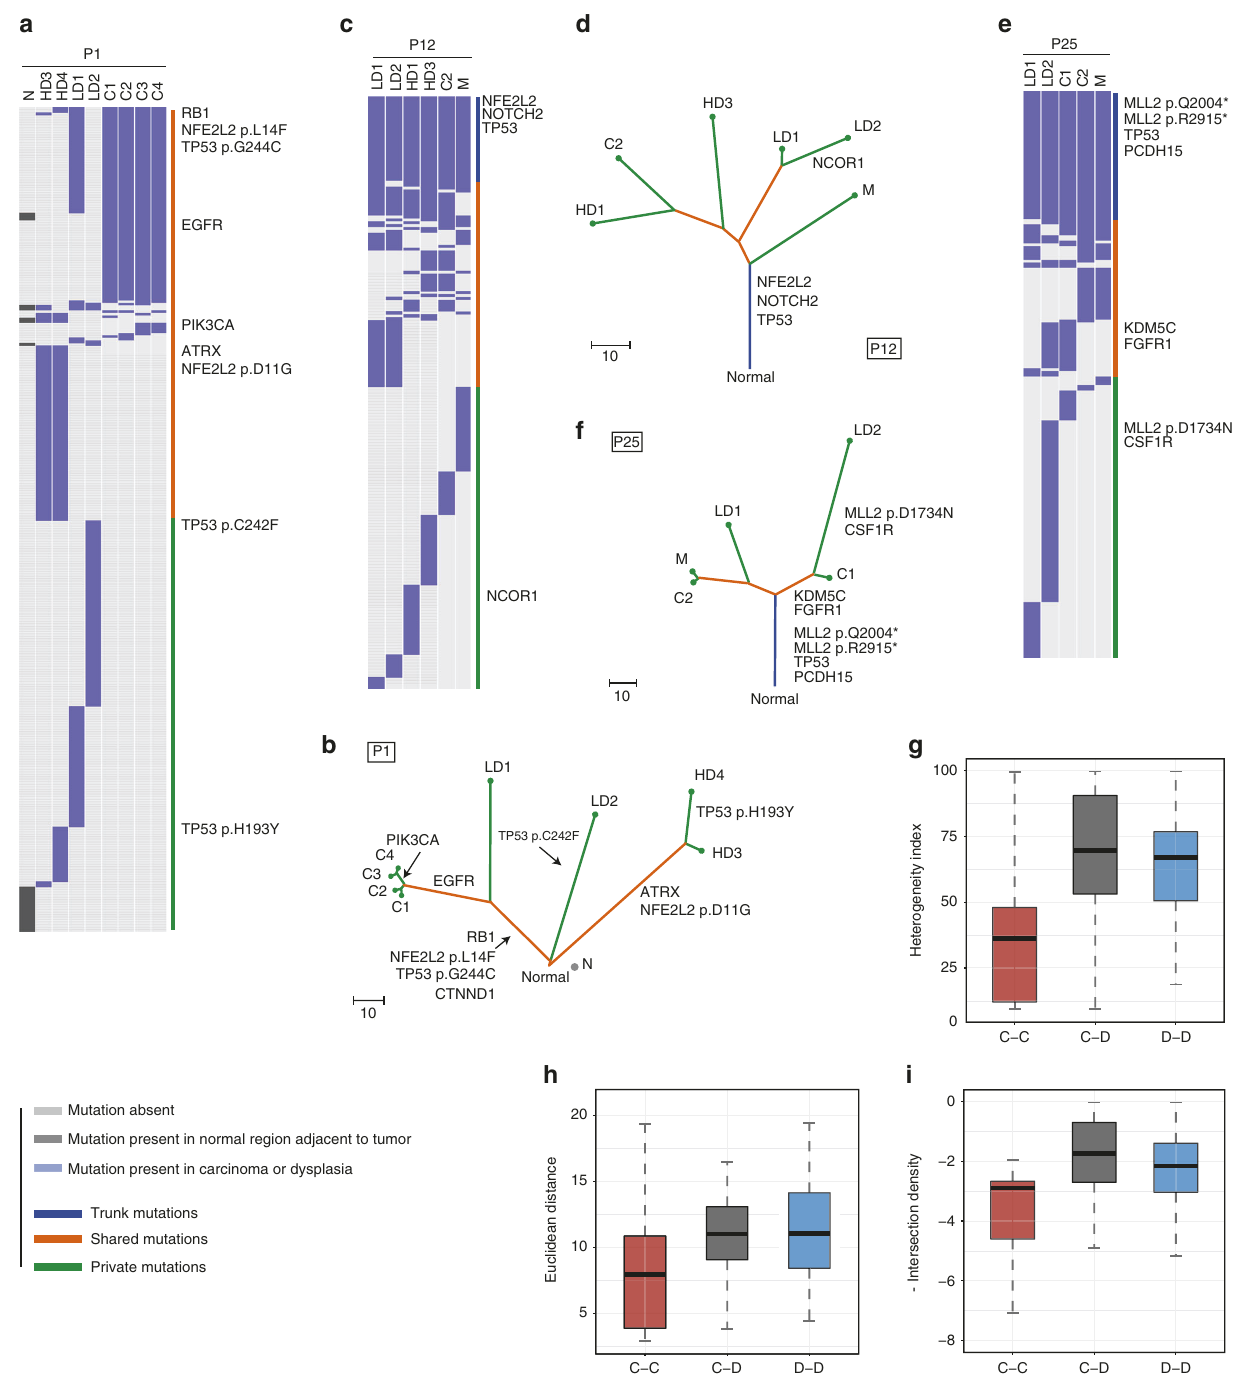
Fig. 3 Regional distributions of somatic mutations and phylogenetic trees of typical cases. a – f Heat maps showing the regional distribution of all mutations among different samples (normal epithelial tissue, dysplasia and carcinoma) in each case. Mutations are further divided into three categories: present in all samples ( dark blue ), present in more than one but not all samples ( orange ), and present in only one sample ( green ). Phylogenetic trees are constructed based on the maximum parsimony algorithm for each case. The color of each line is corresponding to the categories of mutations shown in the heat map. The length of the trunk and branch is proportional to the number of mutations in each sample. There exist some mutations in the heat maps that do not fi t the phylogenetic trees. The possible causes of this may be the absence of mutations due to copy number loss or geographically low level of clone intermixing, as well as other technical noise. g – i Box plots depicting the heterogeneity index (HI), the Euclidean distance and the density of intersecting mutations (in minus value) of pairwise samples in each case. All pairwise samples were divided into three groups: ESCC – ESCC (C-C), dysplasia-ESCC (C-D), and dysplasia – dysplasia (D-D). Kruskal – Wallis test, P = 4.50e − 07 (HI), P = 0.00046 (Euclidean distance) and P = 2.45e −